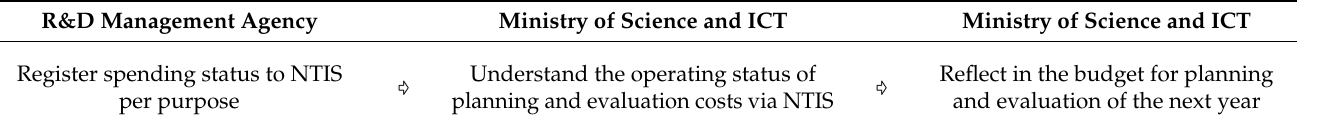
Table 7. Monitoring system for planning and evaluation cost in R&D management agency. R&D Management